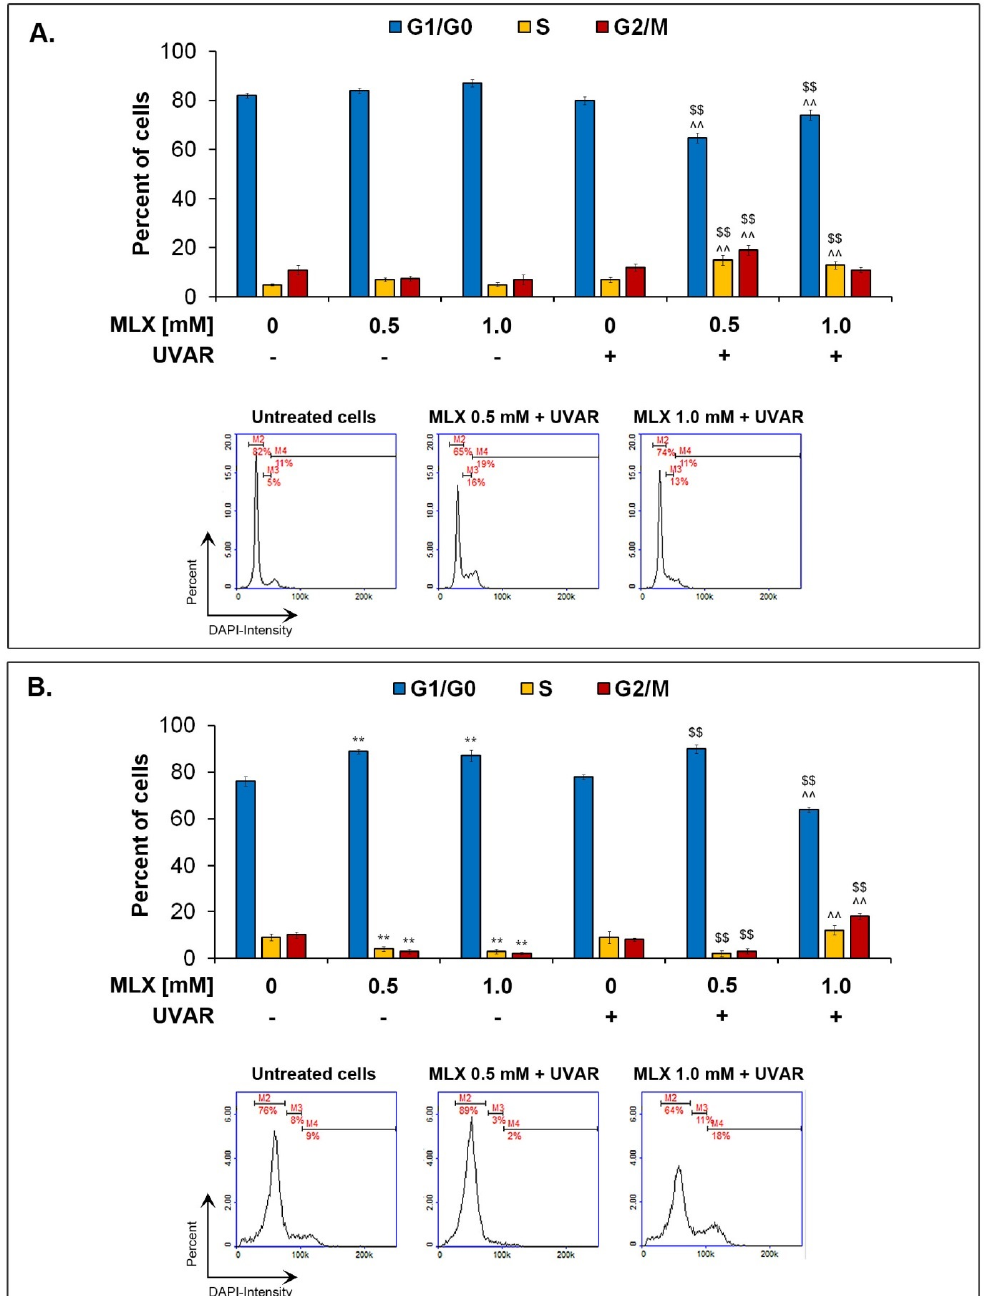
Figure 5. Bar graphics represent the number of cells in a particular cell cycle phases after treatment with MLX and/or UVAR on fibroblasts ( A ). The impact of MLX and/or UVAR on cell cycle on melanocytes ( B ). ** p < 0.01 vs untreated cells (control), $$ p < 0.01 vs irradiated cells (not treated with meloxicam), ^^ p < 0.01 vs corresponding sample not treated with UVAR.